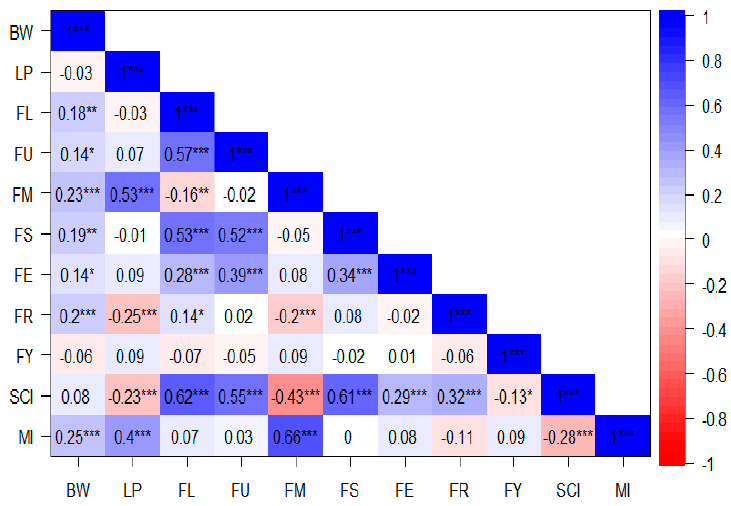
Figure 3. Pearson’s correlation of the 11 traits for the F 2:3 in three environments. *, **, ***: significant levels of 0.5, 0.01 and 0.001 respectively. BW: Boll weight; LP: lint percentage; FL: fiber length; FU: fiber uniformity; FM: fiber micronaire; FS: fiber strength; FE: fiber elongation; FR: fiber reflectance; FY: fiber yellowness; SCI: spinning consistency index; MI: mature index. For the units, see in Figures 1 and 2.